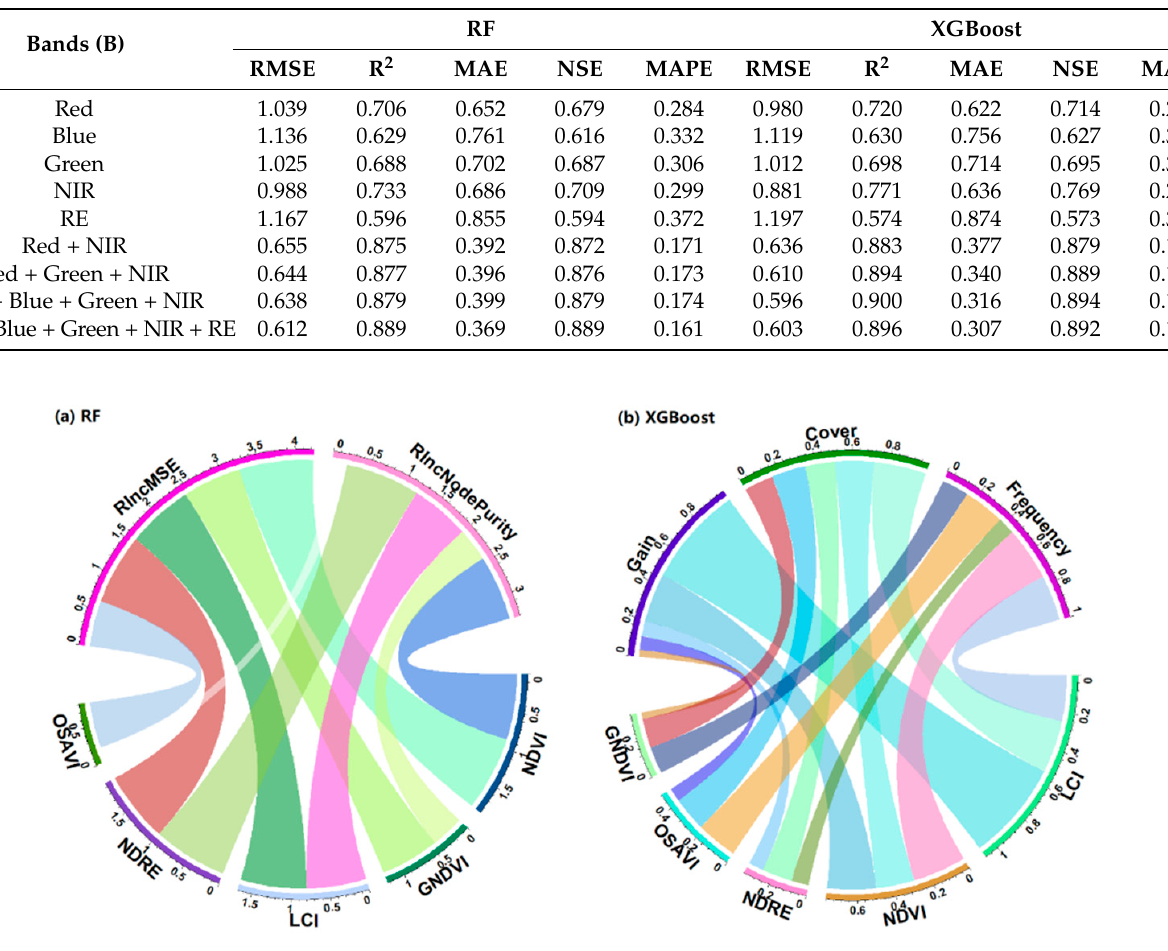
Figure 10. Important feature selection analysis with vegetation indexes (VIs) as input variables by random forest model (RF, a ) and Extreme Gradient Boosting model (XGBoost, b ). IncMSE is the order of increase in mean square error, and IncNodePurity is the increase in node purity. For XGBoost, using LCI as the input variable had slightly higher accuracy than NDRE, which was different from RF (Figure 11). The R 2 and the RMSE with LCI were 0.881 and 0.879, respectively, which increased 1.03% and 1.15% compared with NDRE. Moreover, prediction accuracy (test process) of LAI for the four VIs except OSAVI was also very close, which was similar to the RF. The ranges of R 2 , NSE, RMSE, MAE, and MAPE of the four VIs except OSAVI were 0.883–0.881, 0.851–0.879, 0.637–0.708, 0.397–0.431, and 0.173–0.188, respectively (Table 3). The lowest accurate VI was also OSAVI, which decreased 7.71% and 7.96% of R 2 and NSE, while it increased 25.59%, 34.00%, and 34.10%, respectively, compared with using LCI as the single input variable. However, putting more than one VI together as a combination could not improve the prediction accuracy obviously, which was similar to RF. For example, the most accurate combination of VIs was NDVI, GNDVI, LCI, and NDRE in XGBoost; R 2 and NSE of this combination were 0.890 and 0.886, respectively, only increasing 1.02% and 0.80% compared with using LCI as the single input variable. Meanwhile, RMSE, MAE, and MAPE of the above combination were 0.617, 0.341, and 0.148, which decreased 3.14%, 14.1%, and 14.5% compared with using LCI as the single